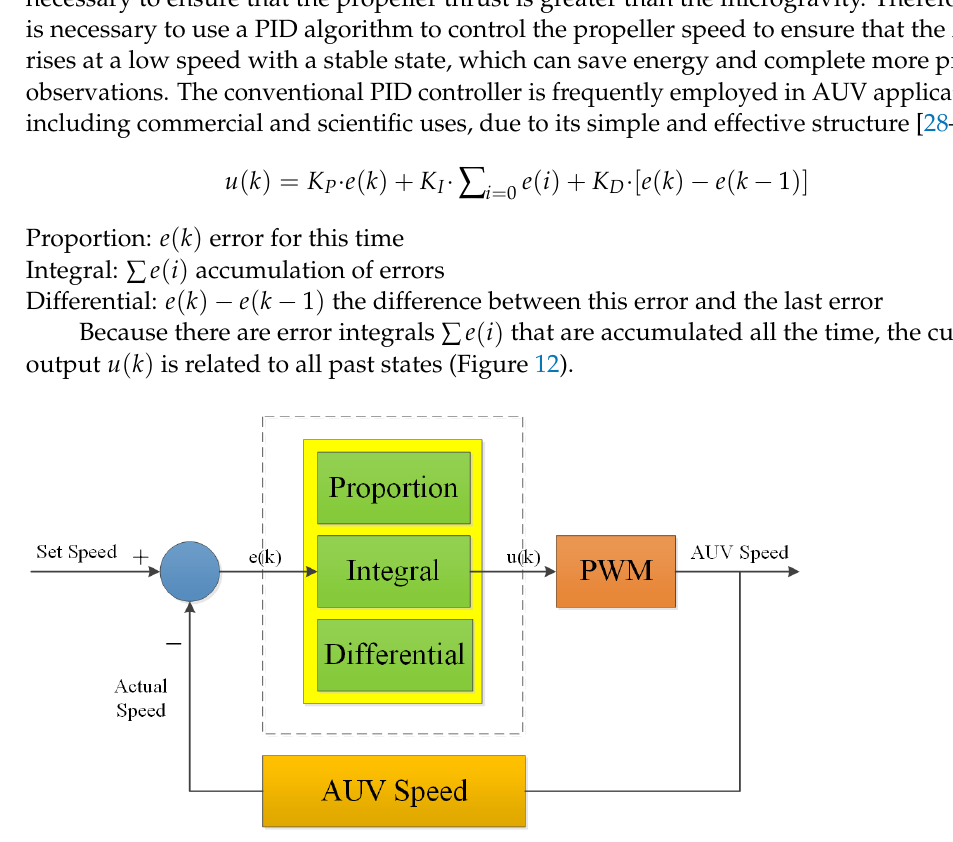
Figure 12. Profile AUV controlled using a PID algorithm .